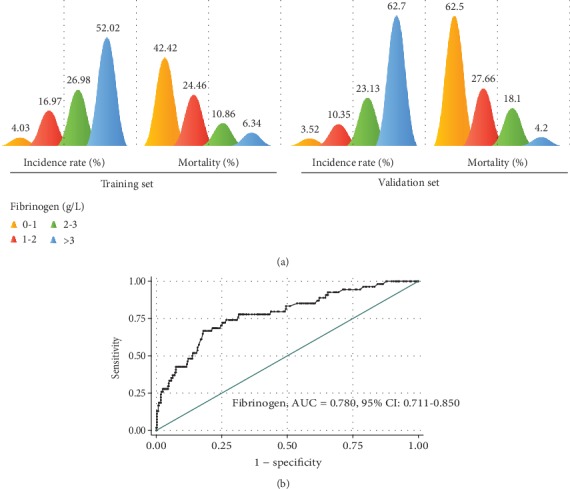
Fibrinogen as a prognostic predictor for hospital mortality. (a) The incidence and mortality rate in pediatric patients with different levels of fibrinogen (fibrinogen level: yellow: 0-1 g/L; red: 1-2 g/L; green: 2-3 g/L; and blue: >3 g/L) in the training set (left) and the validation set (right). (b) ROC analysis of fibrinogen as a prognostic predictor for hospital mortality in the validation set.